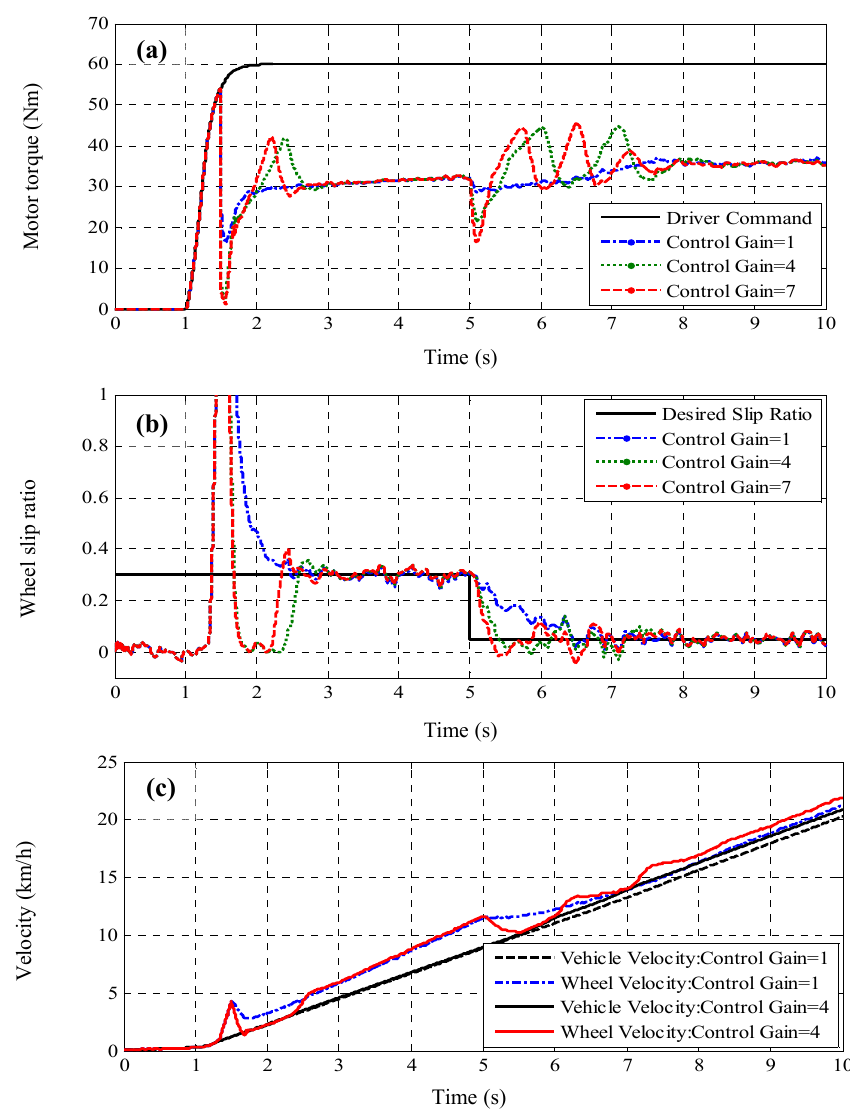
Figure 12. Simulation results for the proposed wheel slip controller (by CarSim software): ( a ) Motor torque; ( b ) Wheel slip ratio; ( c ) Wheel velocity and estimated vehicle